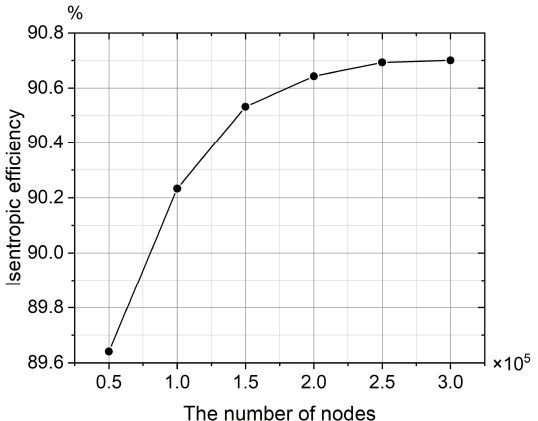
Figure 3. The efficiency distribution with the number of nodes for the grid independence test.